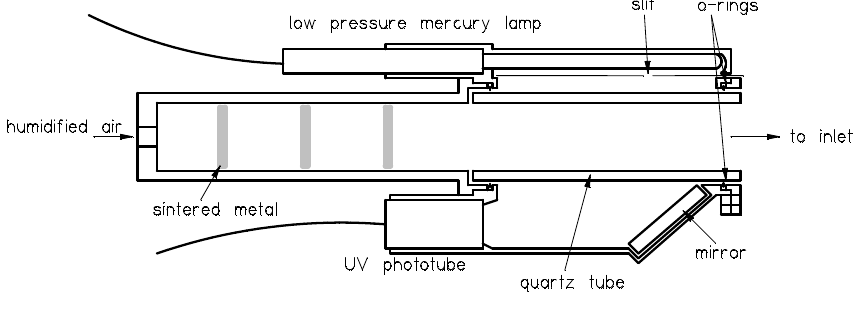
Fig. 2. Schematic of new calibration